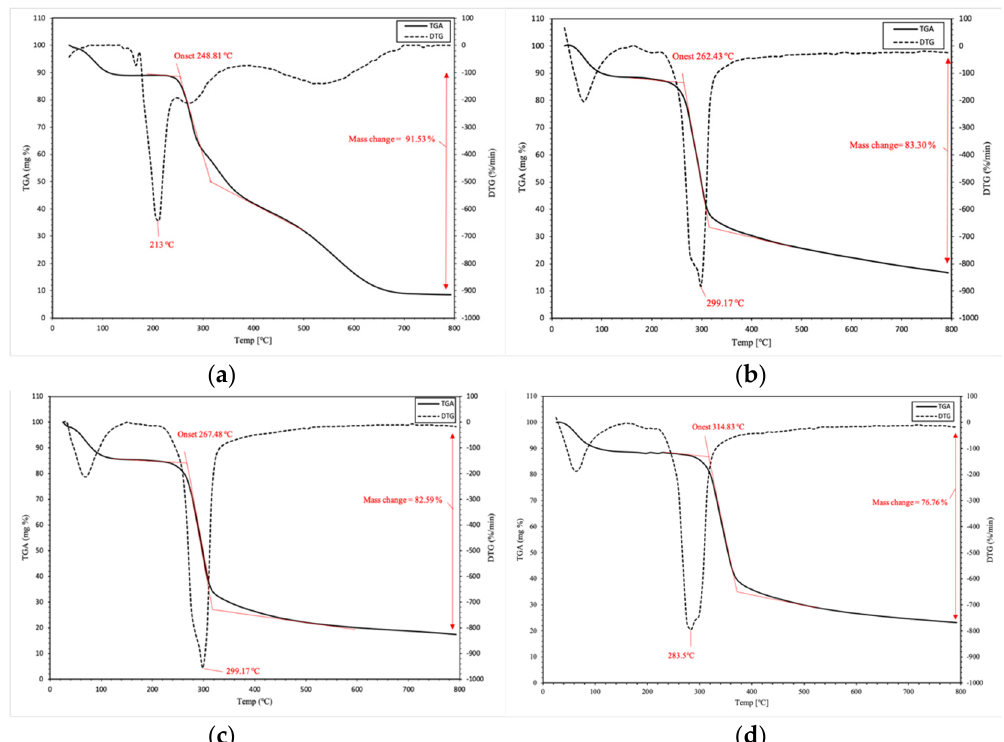
Figure 11. Thermogravimetric analysis (TGA) and differential thermogravimetry (DTG) of starch ( a ), St − g − (MA − DETA) (G% = 15) ( b ), (G% = 19.06) ( c ) and (G% = 27.44) ( d ).